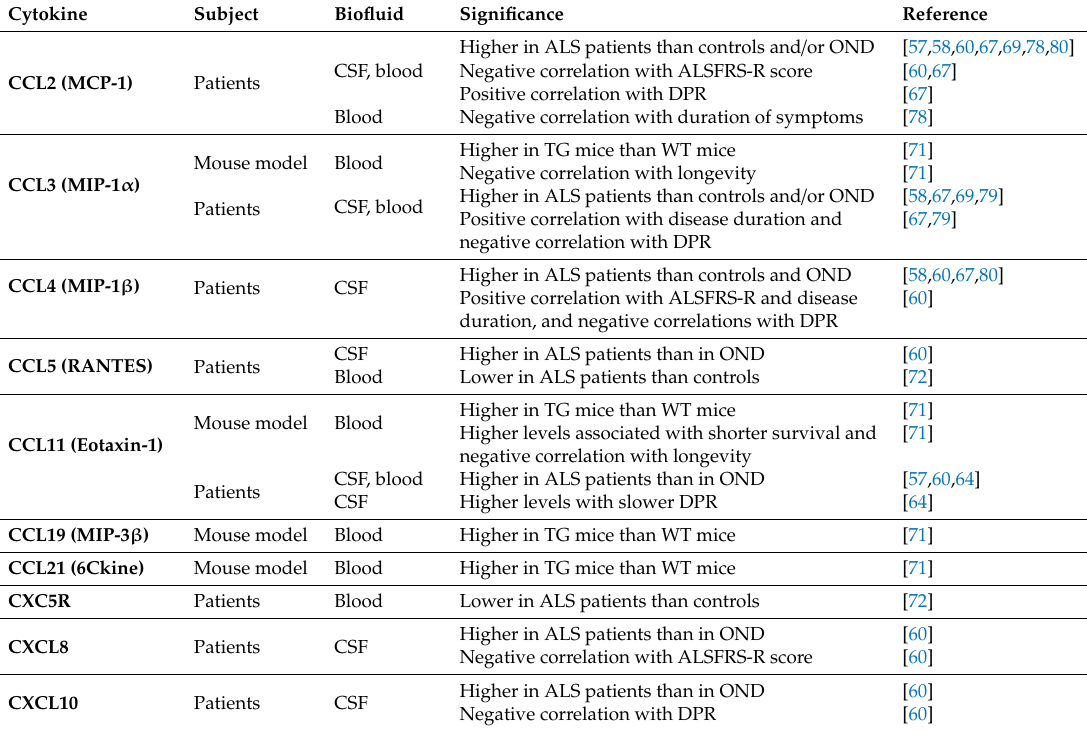
Table 5. Chemokines found dysregulated and proposed as biomarkers in biofluids from ALS animal models and